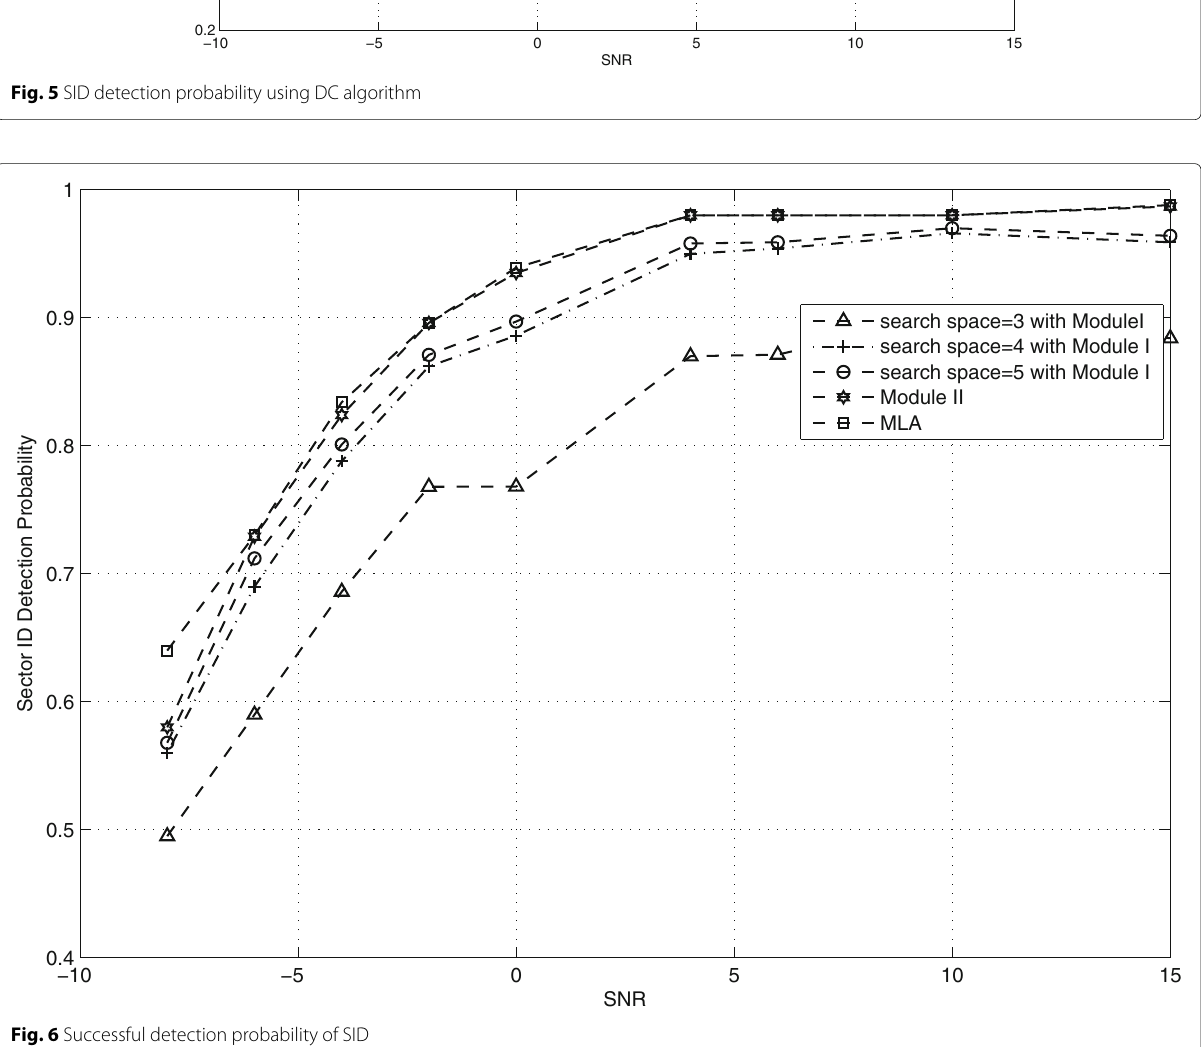
Fig. 5 SID detection probability using DC algorithm